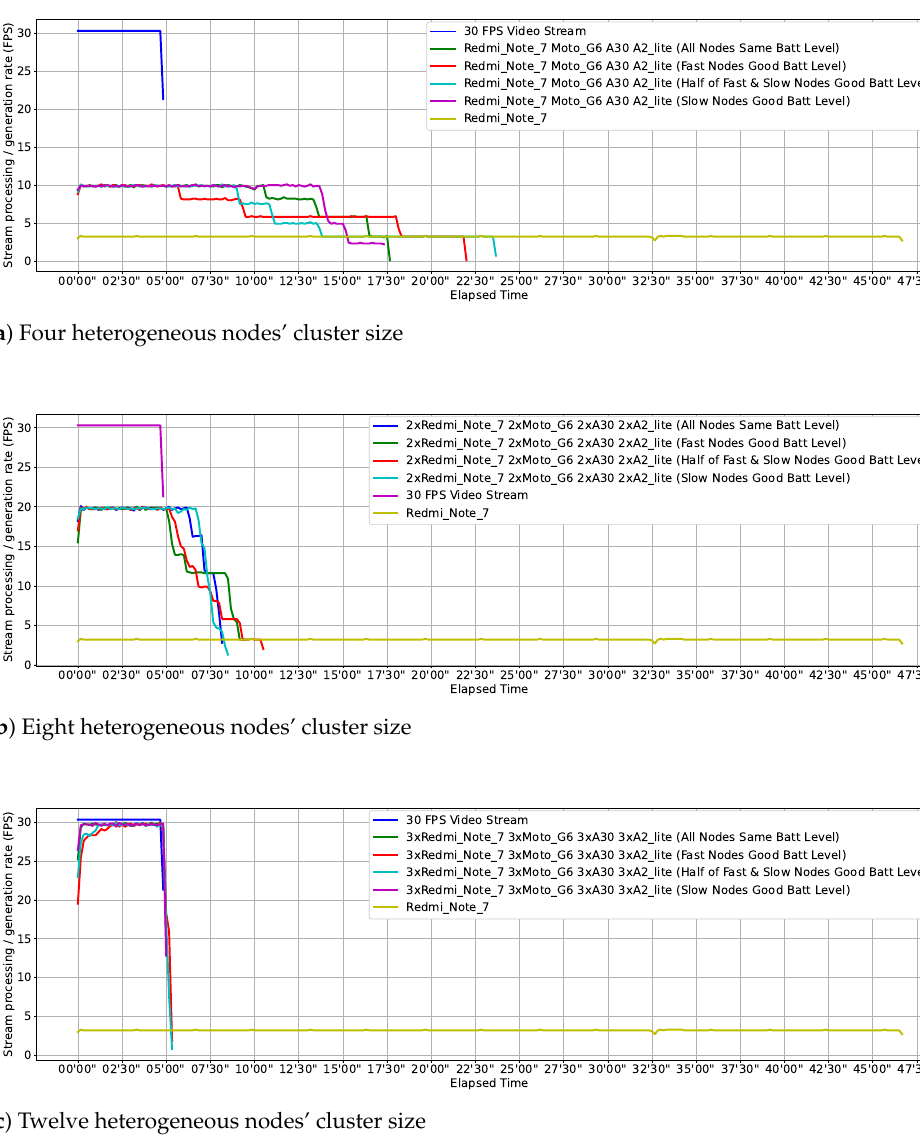
Figure 13. Object detection using the ComTECAC scheduling heuristic over a 5-min, 30 FPS video